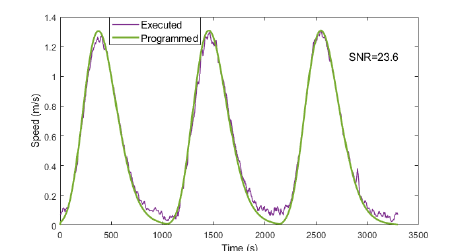
Figure 10. Lognormal speed profile programmed and